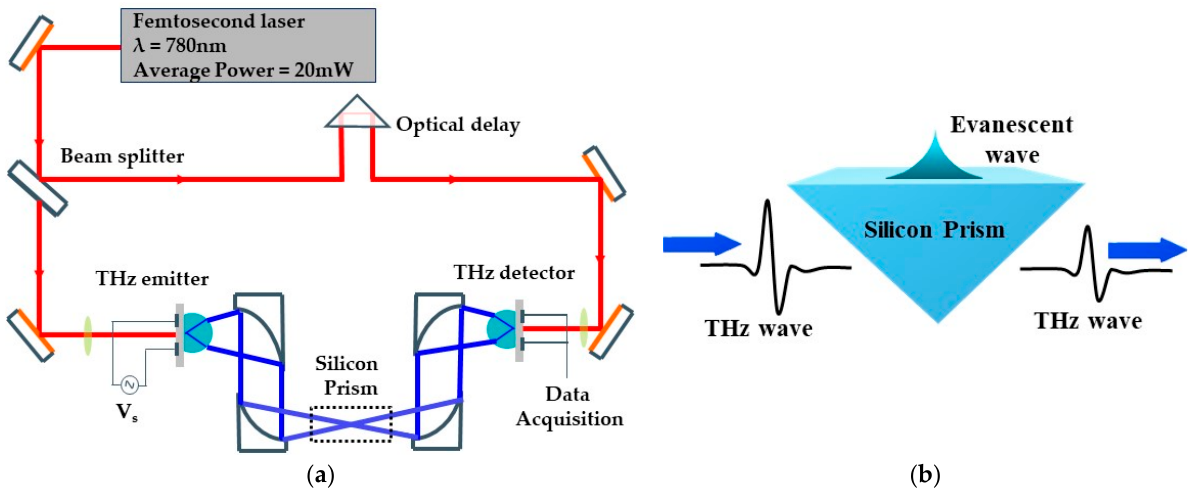
Figure 1. ( a ) Schematic diagram of the THz time domain spectrometer. The dotted line shows the position of the Silicon prism in the spectrometer. ( b ) Schematic diagram of a Silicon prism.